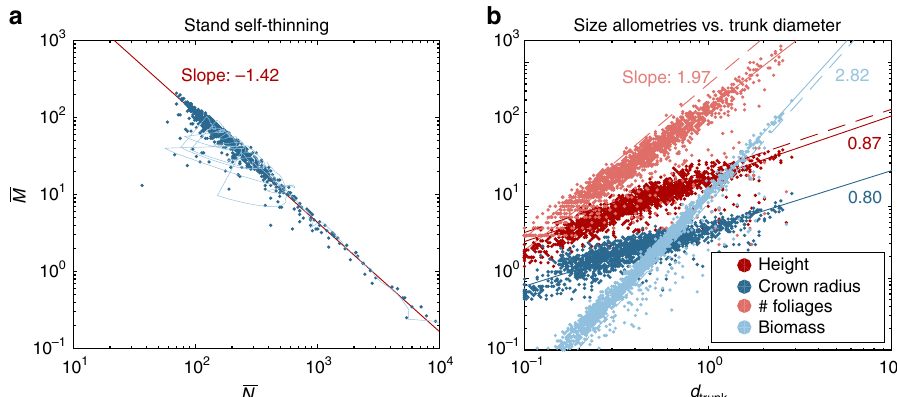
Fig. 3 Allometric scalings. a For the 32 forests of the fi rst round, the effective biomass M (unit L 3 ) is plotted as a function of the effective number of trees N , for the fi rst 500 yrs (the light blue line shows the history of a particular forest). Only 2% of the dataset is shown, but the red line shows a linear regression fi t on the entire dataset with N as weight. Large excursions to the left of the regression line correspond to strong wind events during which a large number of trees can die (Fig. 2b and Supplementary Movie 1). b Each tree in the 32 forests of the fi rst round is extracted after 3000 yrs. Their height H (unit L ), crown radius C (unit L ), number of foliages N and stem biomass B (unit L 3 ) are plotted as a function of their trunk diameter d trunk . For clarity, only 5% of the trees are shown, but the solid lines show reduced major axis regression (RMA) on the whole dataset, with N as weight. The dashed lines show the results of the AMT model (see below)